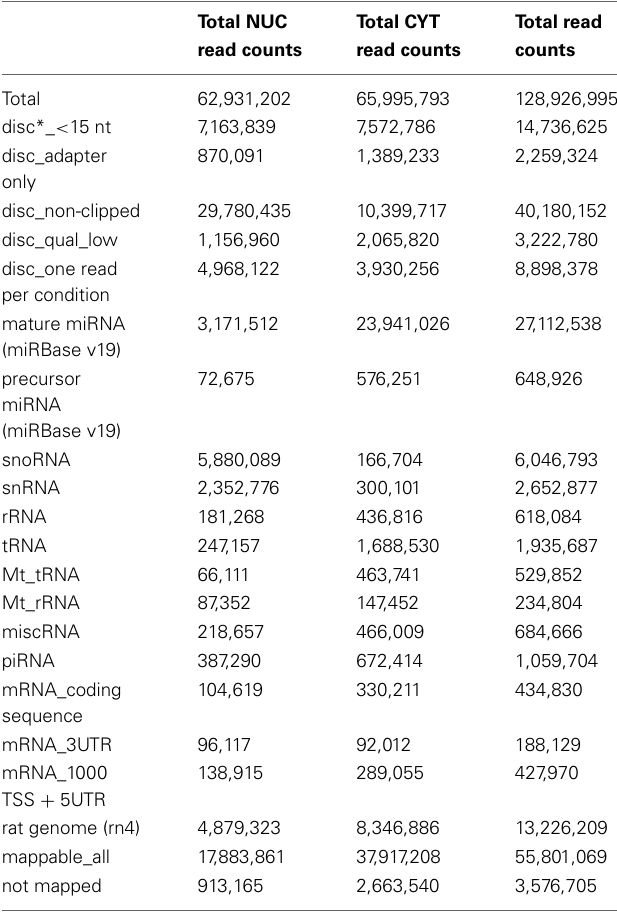
Table 1 | The summary of small RNA deep